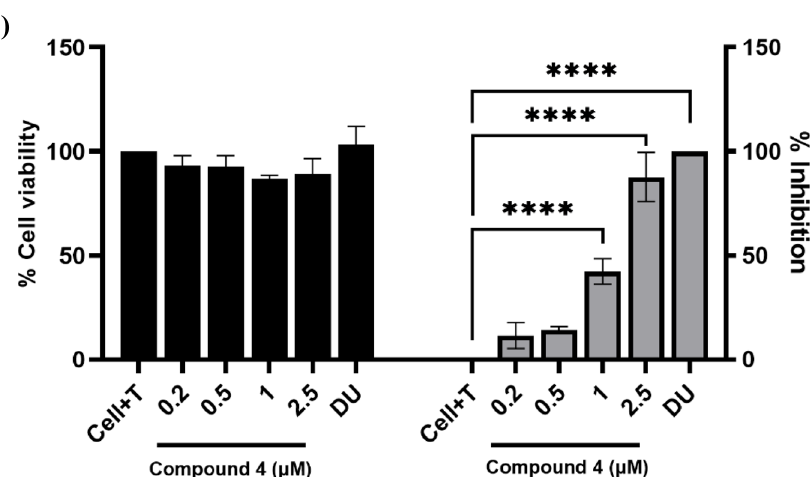
Figure 5. In vitro evaluation of the inhibition of SRD5A1 activity by the caffeic acid N -[3,5-bis(trifluoromethyl) phenyl] amide ( 4 ) using a HaCaT cell-based assay with direct DHT detection by HPTLC. ( a ) HPTLC chromatogram. Lanes 1−4, dihydrotestosterone (DHT) standards at different concentrations. Lane 5, HaCaTs (Cell) treated with 10 μM testosterone (T). Lanes 6 − 10, HaCaTs treated with compound 4 at different concentrations. Lane 11, HaCaTs treated with 2.5 μM dutasteride (DU). Lane 12, Cell refers to HaCaTs. Lanes 12−16, testosterone (T) standards at different concentrations. The concentrations of compound 4 were shown at the bottom of each lane in μM. ( b ) The inhibition of SRD5A1 activity and HaCaTs viability in the treated cells. The half-maximal inhibitory concentration (IC 50 ) of compound 4 against SRD5A1 activity was 1.44 ± 0.13 µM. The data of three independent experiments were represented as means ± SD. The viability and inhibitory of the compound-treated cells was compared to that of the untreated controls; **** p <